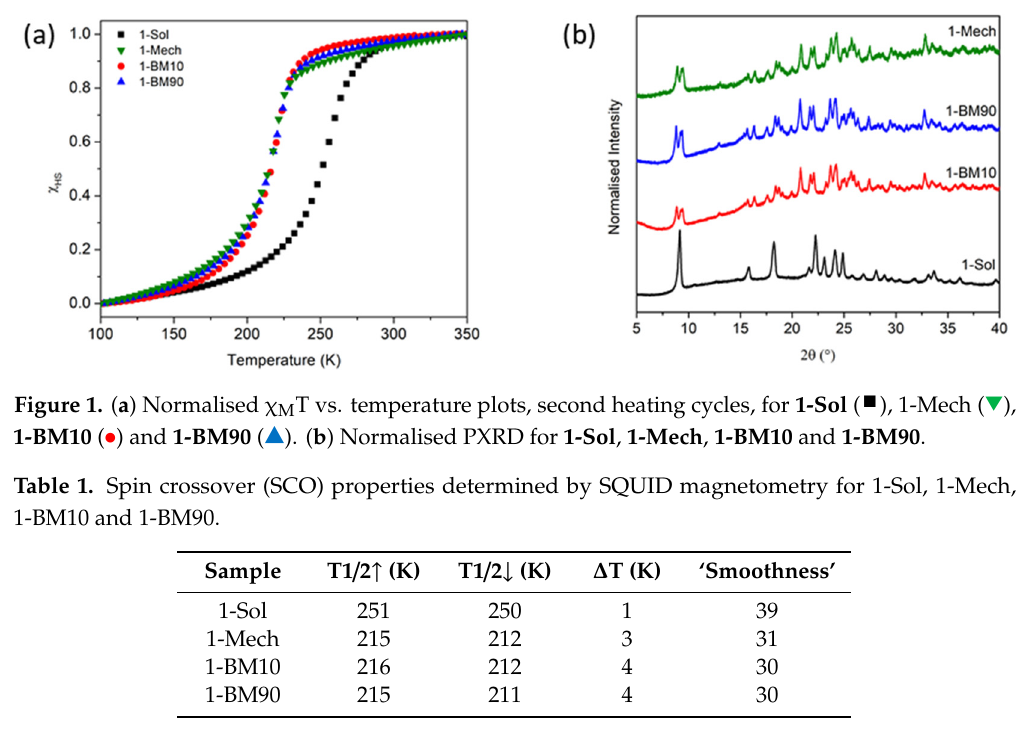
Figure 1. ( a ) Normalised χ M T vs. temperature plots, second heating cycles, for 1-Sol ( ∎ ), 1-Mech ( ▼ ),